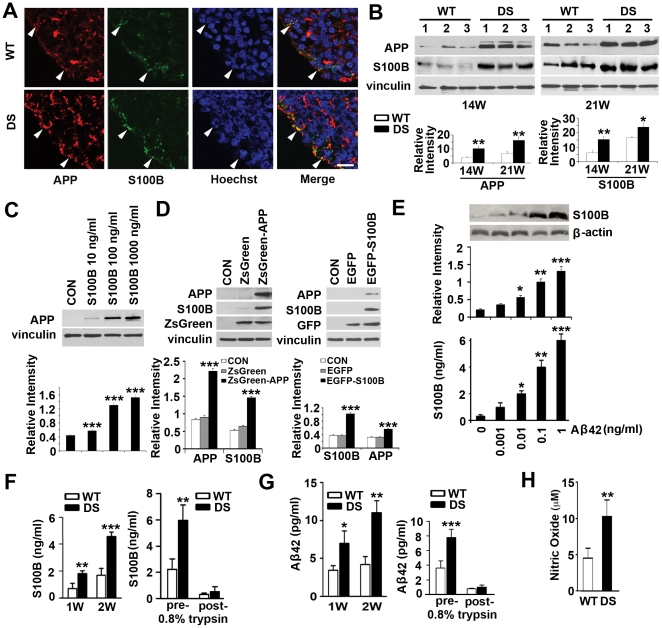
Reciprocal up-regulation of secreted S100B, APP and oxidative stress in DS HNPs.(A) Fluorescent photomicrographs demonstrate increased intensity of staining for both APP (rhodamine) and S100B (fluorescein, counterstained with Hoechst 33342) within DS neural progenitors along the VZ of the 18W GA fetal cortex compared to normal age-matched controls. White arrowheads show the colocalizations of APP and S100B along the VZ. (B) Western blot analyses confirm upregulation of both these proteins within the cortex of the DS brains of multiple independent samples at an age dependent manner (n = 3 age-matched control and DS fetal tissues, 14W and 21W GA). (C) Incubation of S100B (10–1000 ng/ml) for 24 hours in normal cultured HNPs dose-dependently increases APP levels; (D) S100B levels in the cytoplasm are increased with APP overexpression for 4 days, and vice versa, as shown by western blot. (E) Western blot and ELISA assay show a dose-dependent increase in S100B expression and secretion into the culture medium after Aβ42 stimulation for 24 hours. (F) Longer term (1–2 weeks) culturing of DS HNPs results in a progressive increase in the expression of S100B. The increased levels of S100B are largely due to soluble, extracellular S100B as trypsin treatment of the media can degrade the protein. (G) A similar increase in Aβ42 levels is appreciated in DS HNPs cultured over time. Increased levels of Aβ42 are also largely due to soluble, secreted protein that is degraded with trypsin treatment. Prior findings have shown that S100B or amyloid can lead to increased ROS generation. Consistent with these findings, there is an increase of oxidative stress in DS HNPs, as showed by nitric oxide assays (H). Scale bars are 12.5 µm in A; data are represented as mean +/− STDEV, * p-value<0.05, ** p-value<0.01, *** p-value<0.001 by two tailed t-test.